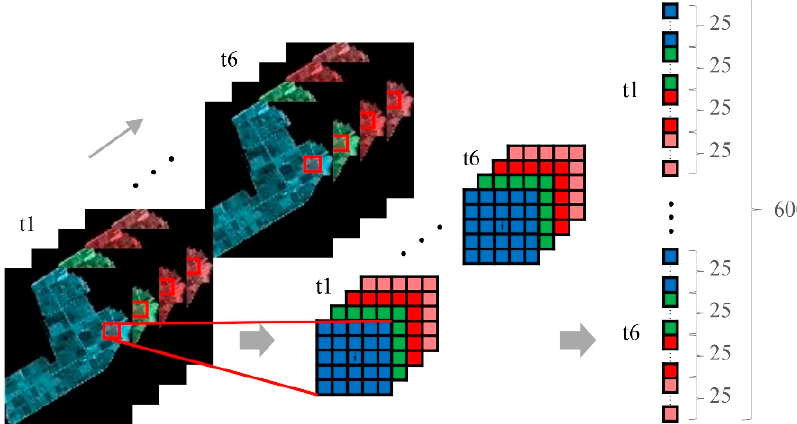
Figure 3. An overview of the feature extraction process (window size is set to 5